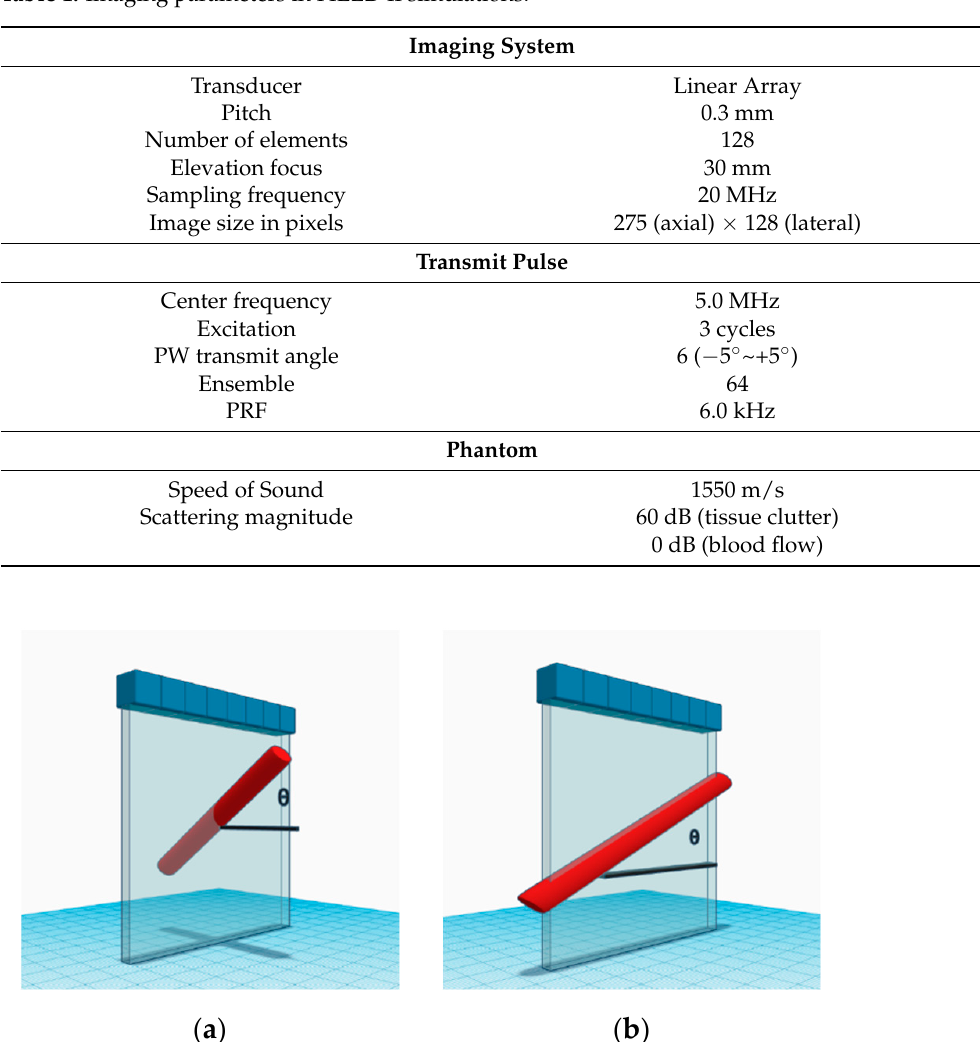
Table 1. Imaging parameters in FIELD II simulations.